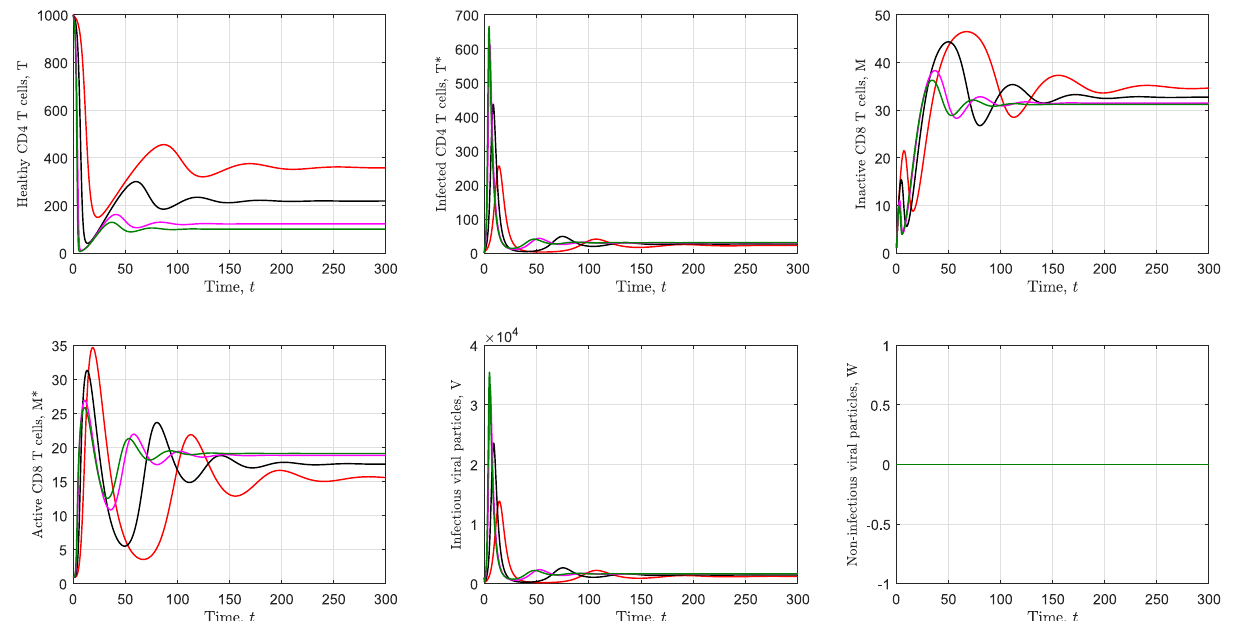
Figure 2. Numerical solutions of system (7), considering the parameters in Table 2, simulating 300 days, varying the CD4 T cell infection probability β , taking as fixed the value of the probability of the active CD8 T cells eliminating the infected CD4 T cells, γ = 2 × 10 − 3 and considering that ART is not used, that is, the RTI and PI are in null values, u i = 0 with i = 1,2. When β = 1.5 × 10 − 5 is the red curve with R 0 = 1.2168, β = 2.5 × 10 − 5 is the black curve with R 0 = 2.0280, β = 4.5 × 10 − 5 is the magenta curve with R 0 = 3.6504, and β = 5.5 × 10 − 5 is the green curve with R 0 = 4.4616.